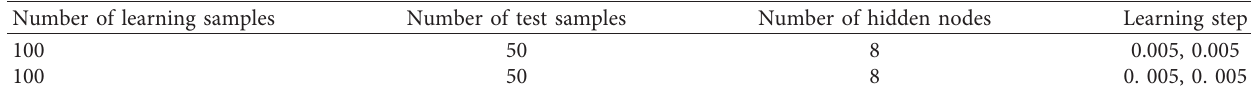
Table 7: Learning step size of the RDCAR algorithm.